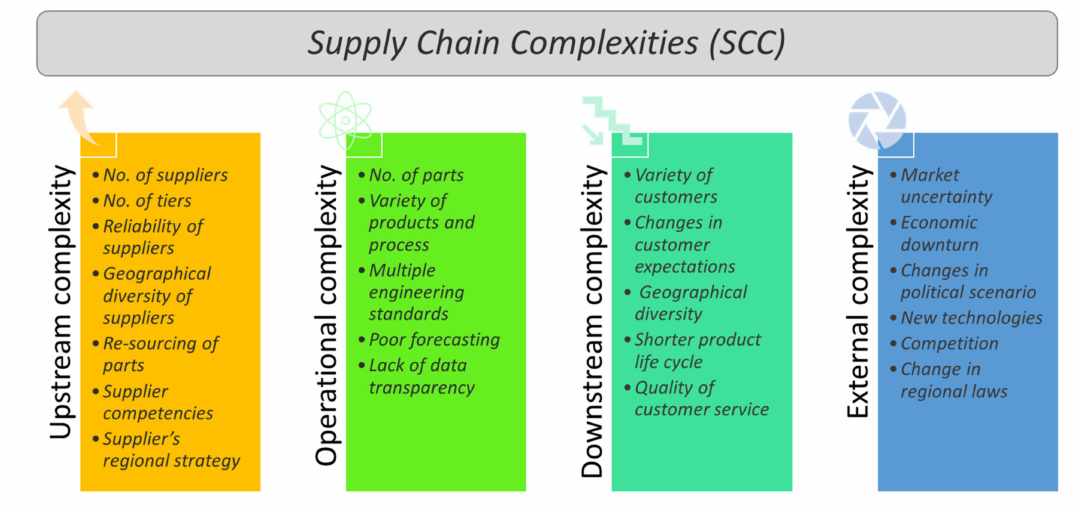
Figure 4. Supply chain complexity categories and their